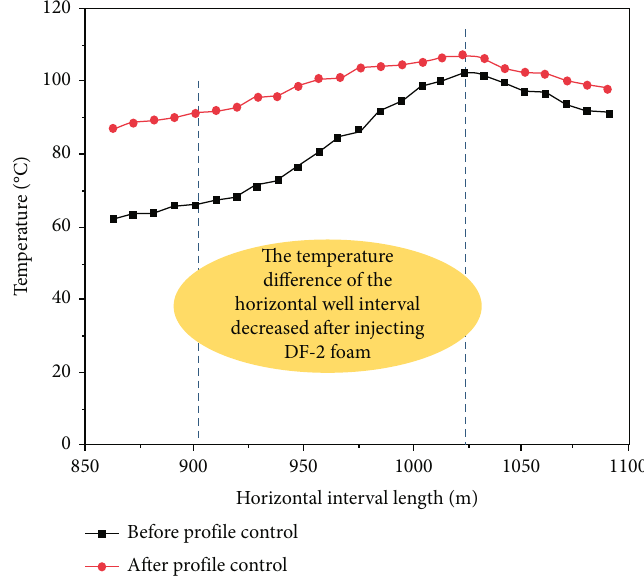
Figure 9: The temperature variation with horizontal well interval